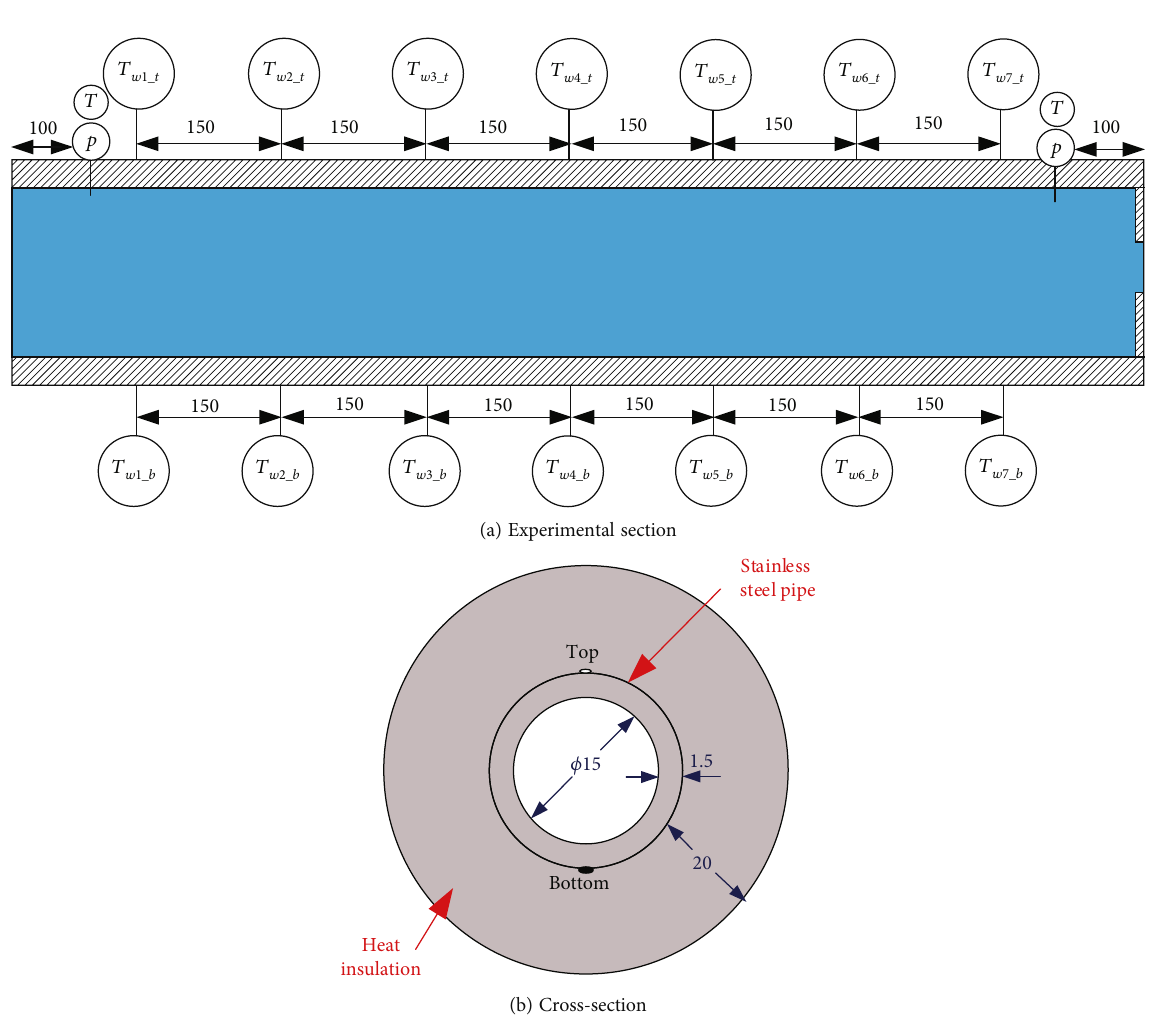
Figure 2: Details on the experimental section, unit: